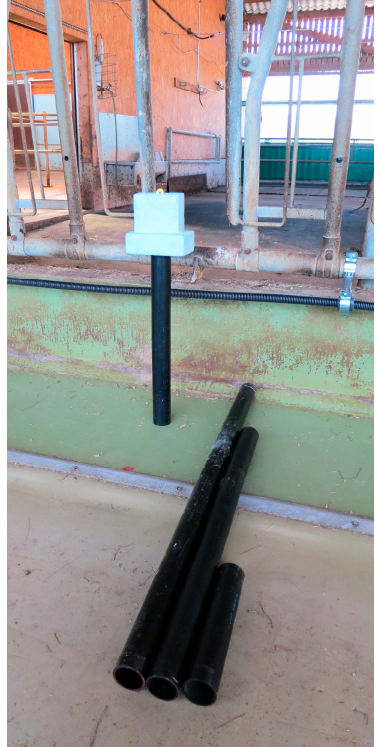
Figure 4. Polystyrene holder with ear tag and polyvinyl chloride (PVC) pipes of different lengths to maintain the targeted height during the measurements.